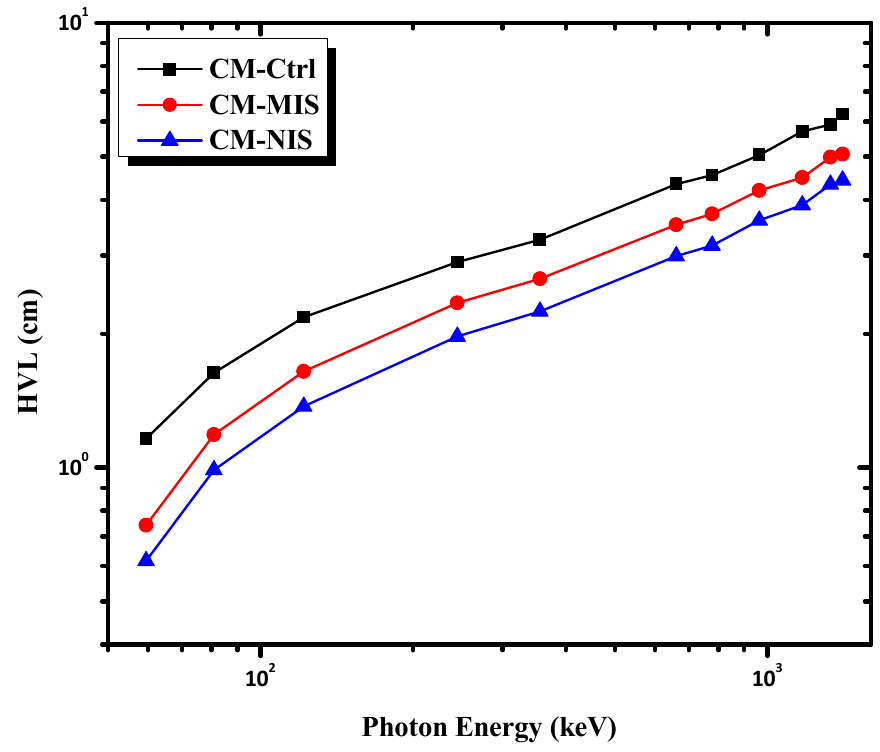
Figure 9. The variation of the HVL as a function of photon energy.